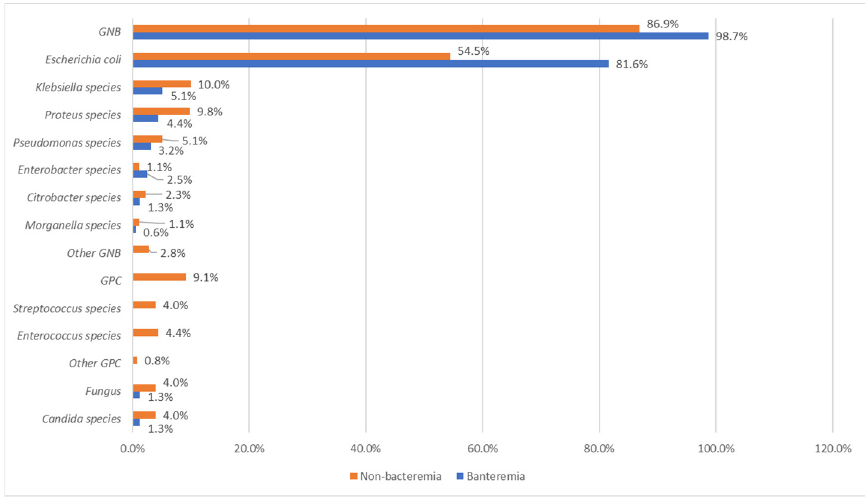
Figure 3. Results of microbiological studies.